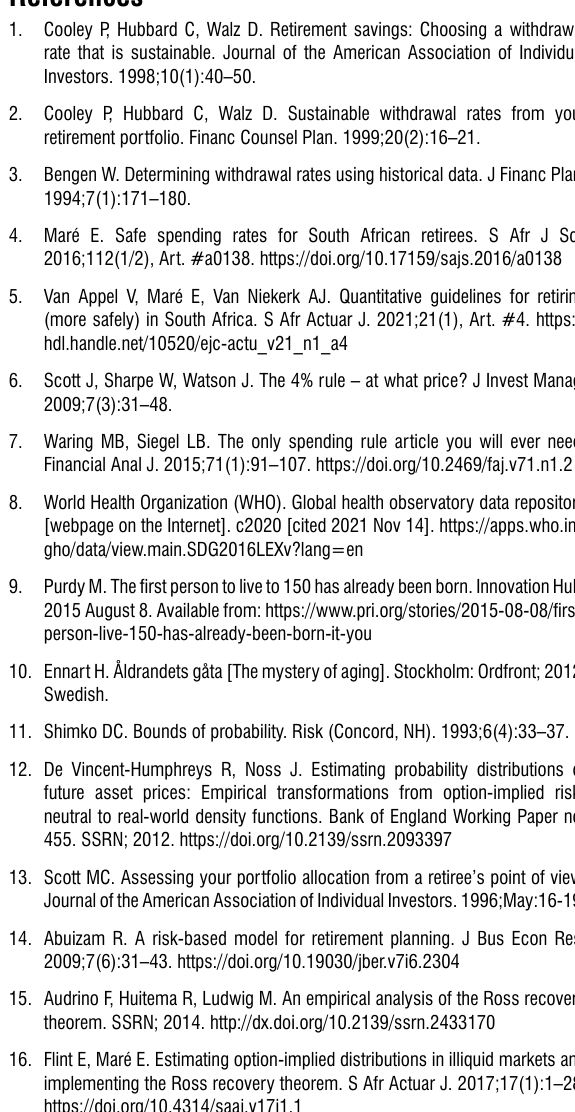
Asset allocation 4% 5% 6% 7% 8% 9% 10% Fixed asset allocation 100% Stocks 256